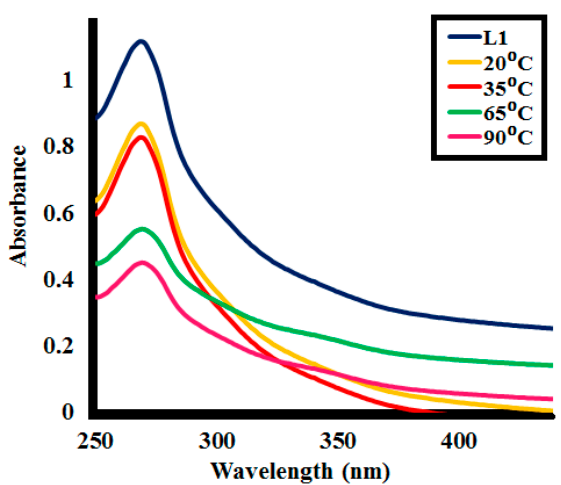
Figure 13. Photocatalytic lignin ( L1 100ppm ) depolymerization by 0.1 g SK9 at the different temperatures after 60 min of catalytic activity. Molecules 2020 , 25 , x FOR PEER REVIEW Table 5. %Lignin ( L1 100ppm ) depolymerization by SK9 (0.1 g) at the different temperatures and the time intervals.